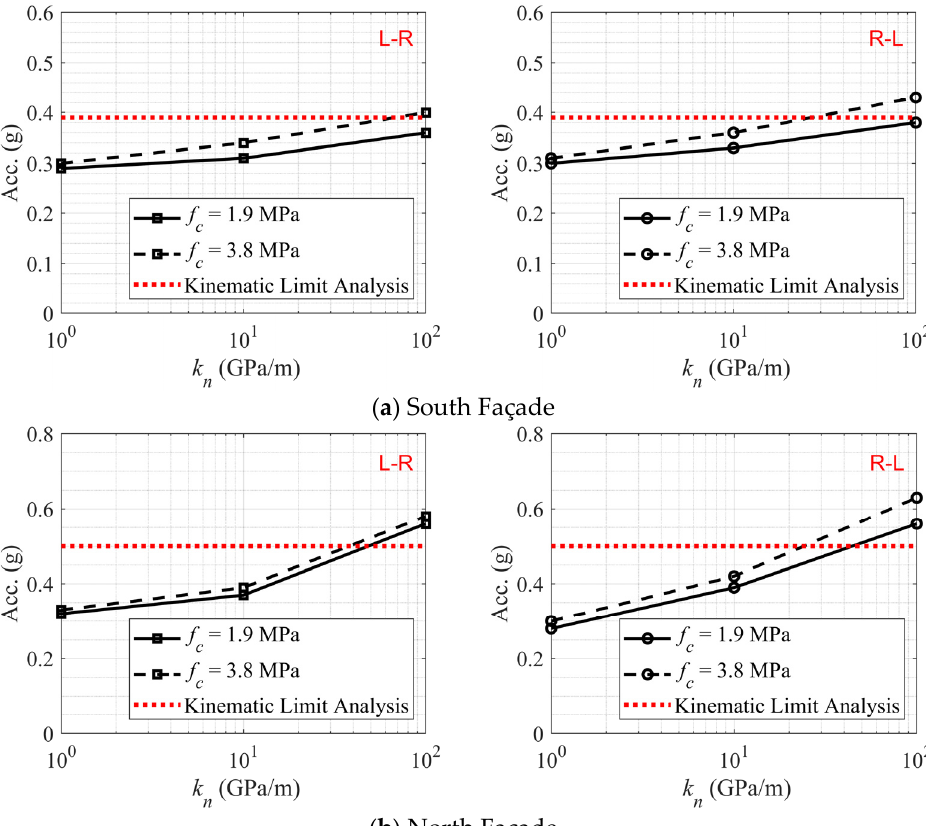
Figure 11. Parametric study on the contact stiffness ( 𝑘 (cid:3041) ) and compression strength ( 𝑓 (cid:3030) ).